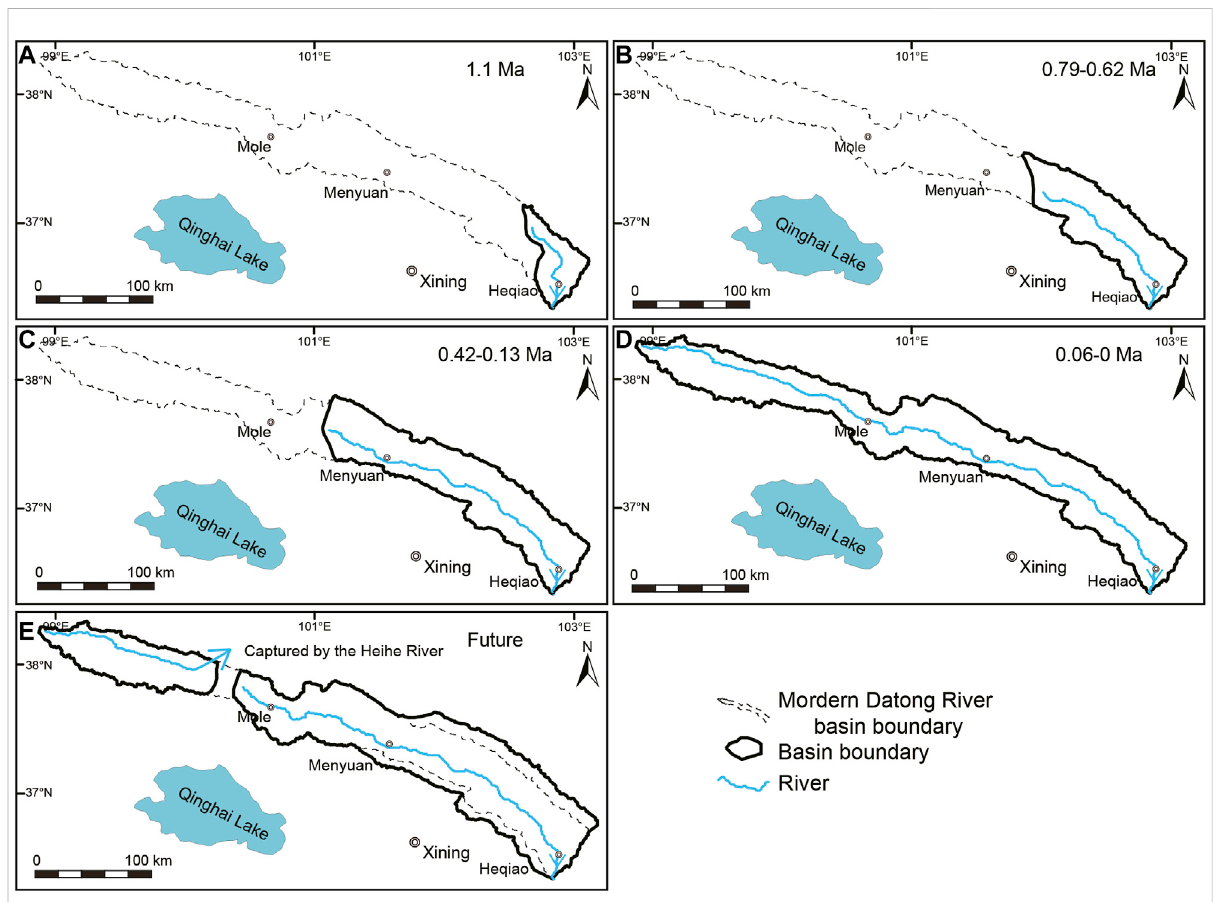
FIGURE 2 Evolution processes of the Datong River [modi fi ed from Ma et al. (2020)]. (A – B) : The modern Datong River began to form at ~1.1 Ma, the drainage basin was limited to the area of the lower modern Datong River at the beginning, and since then, it has gradually extended with headward erosion. (C) : The Datong River channelized into the Menyuan Basin between ~0.62 Ma and ~0.42 Ma (D) : The Datong River captured the upper Datong River between ~0.13 Ma and ~0.06 Ma (E) : In the future, the upper Datong River might be captured by the Heihe River and the basin of lower Datong River will